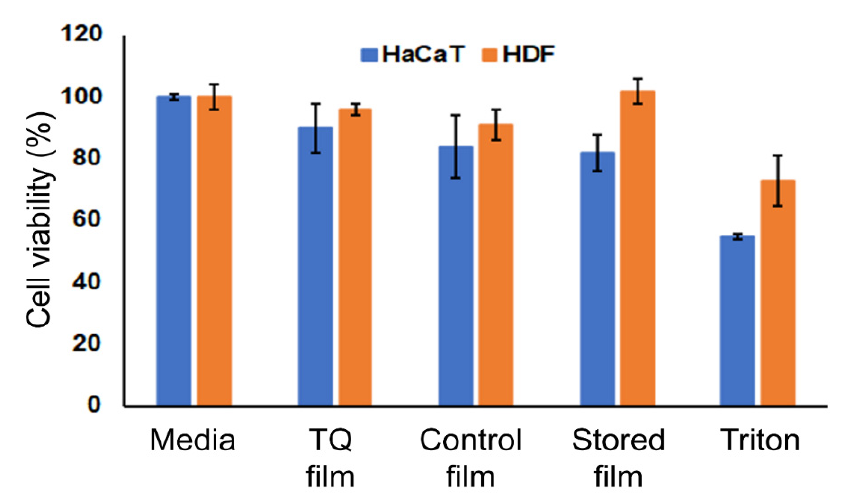
Figure 4. The cytocompatibility study of TQ film. Cell viability of TQ film with HDF and HaCaT cells using alamarBlue ®